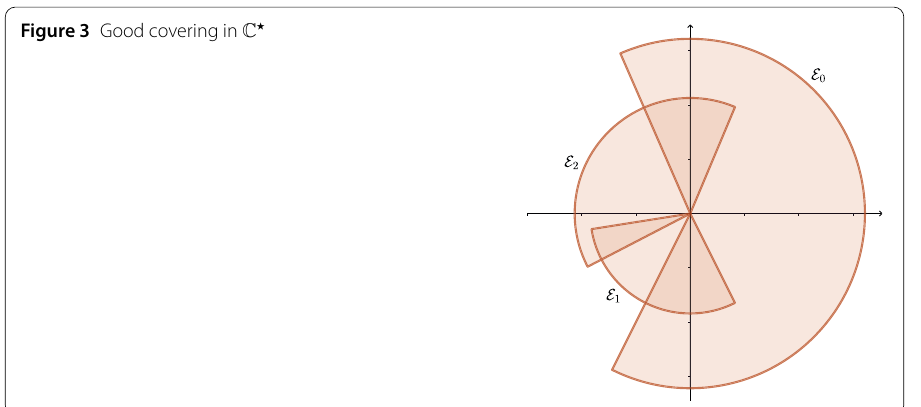
Figure 3 Good covering in C